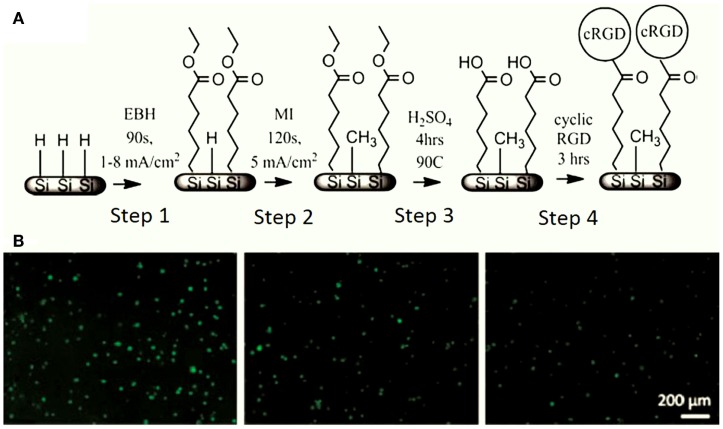
(A) PSi chemical modification by a four-step functionalization cascade. Step 1: electrografting of EBH, Step 2: backfilling with MI, Step 3: ester cleavage in boiling H2SO4, and Step 4: cRGD immobilization. (B) Rat MSC response to cRGD gradient on PSi, with the cRGD density decreasing from left to right. Reprinted from Clements et al. (2011).